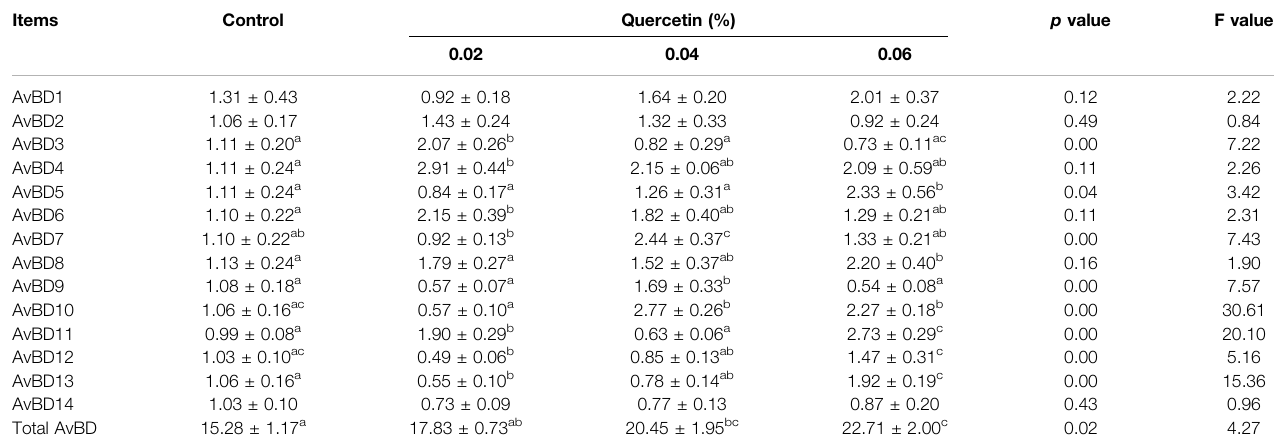
TABLE 8 | Effect of quercetin on the mRNA expression of beta-defensins in the ileum of AA broilers. Items Control